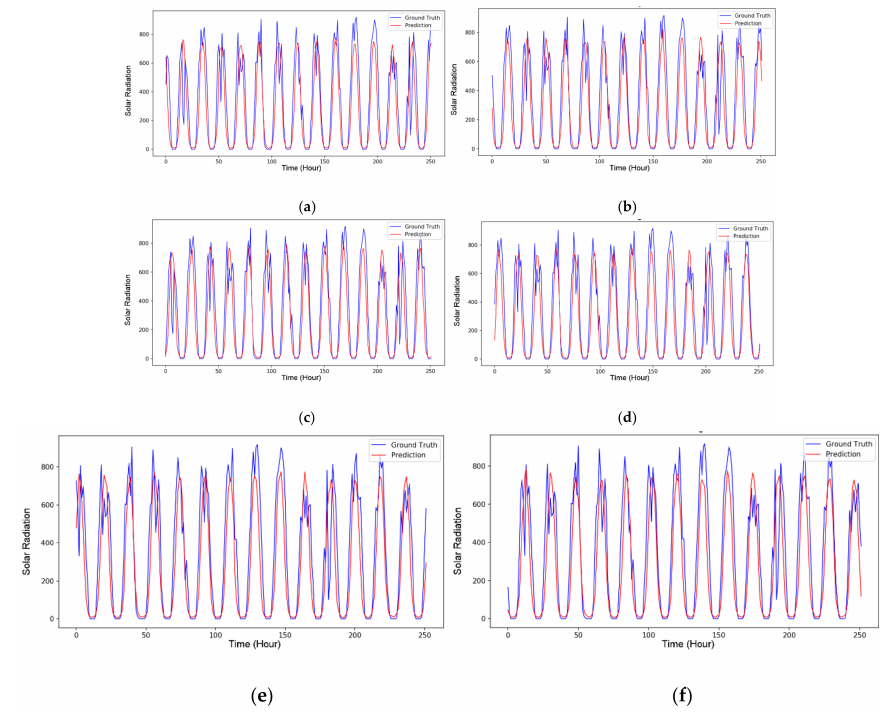
Figure 12. Forecasting results of multilayer perceptron: ( a ) Partial results A; ( b ) Partial results B; ( c ) Partial results C; ( d ) Partial results D; ( e ) Partial results E; ( f ) Partial results F.